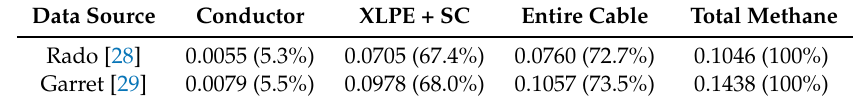
Table 5. Amount of CH 4 (mol/m) present in each cable component at the cable take-up point.